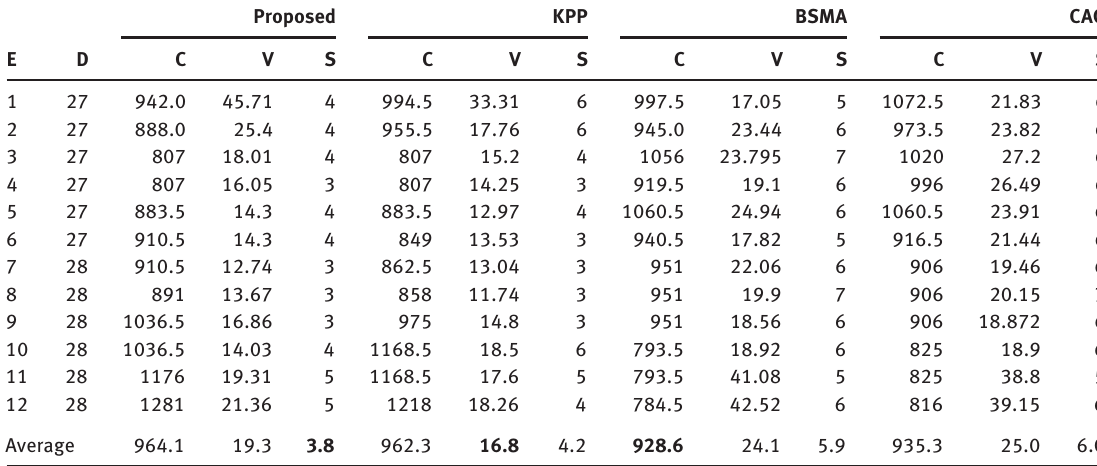
Table 2. Comparison of Dynamic Greedy Algorithm, BSMA, KPP, and